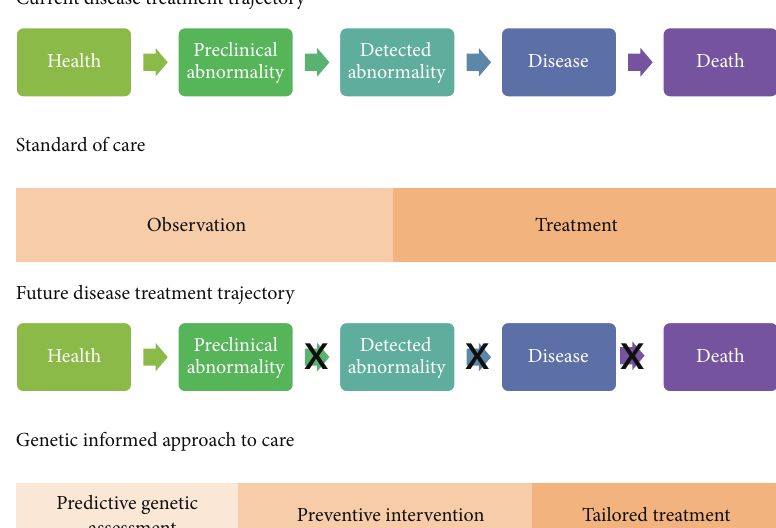
Figure 1: Disease treatment